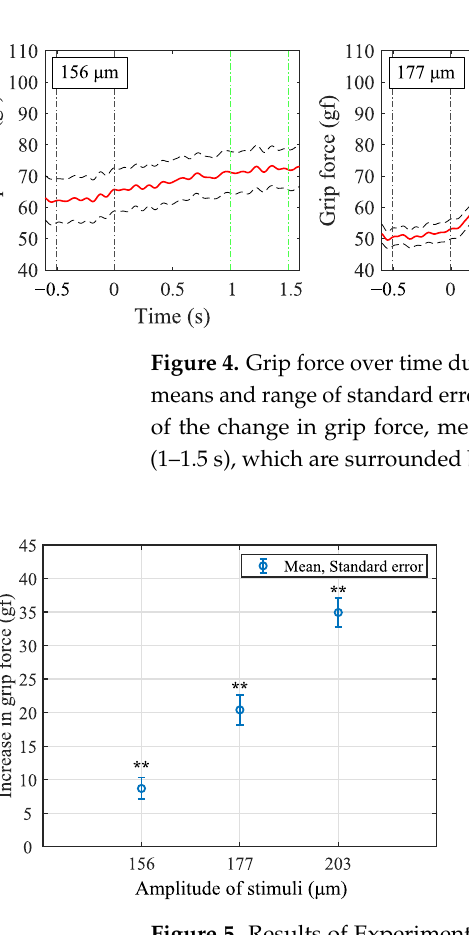
Figure 5. Results of Experiment 2. Three different stimuli with different amplitudes but the same frequency (30 Hz) were used. ( A ) Increase in grip force for three different amplitudes. ( B ) Ranks of per- ceived heaviness. A higher rank number indicates a perception of greater heaviness. * and ** indicate significant differences at the 5% and 1% levels, respectively. There was a positive correlation between the increase in grip force and perceived heaviness ( ρ = 0.77, p = 1.37 × 10 − 7